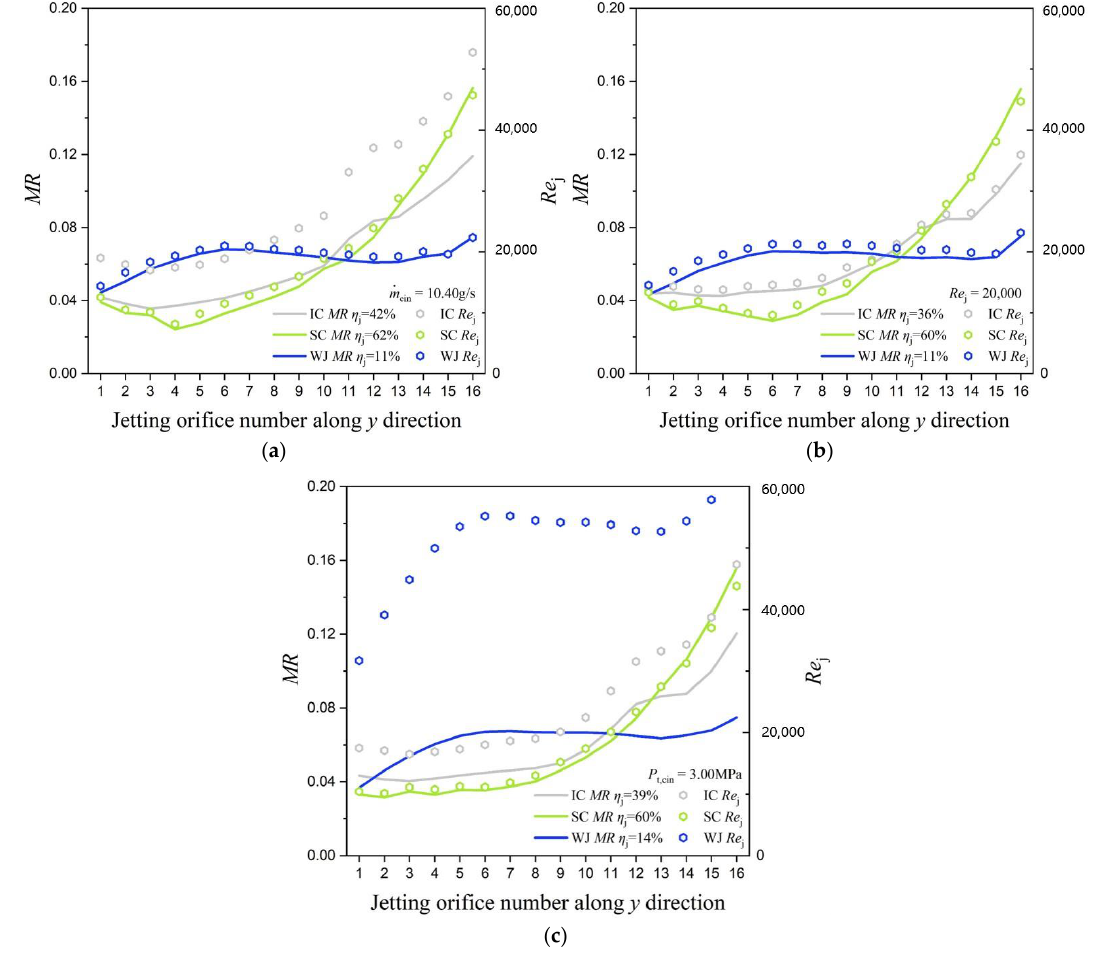
Figure 13. Mass flow rate ratio and jetting Reynolds number comparison among different internal cooling structures; ( a ) Cases with the same m ̇ cin ; ( b ) Cases with the same Re j ; ( c ) Cases with the same P t,cin .